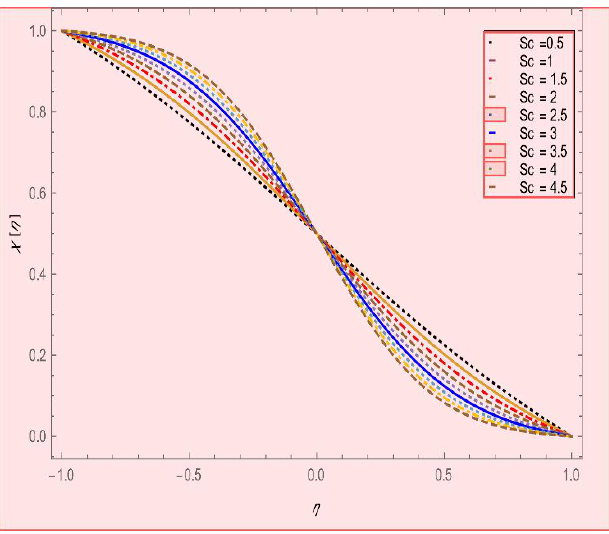
= ϕ = 0.01, Sc = 1, M = 1, Re = − 1, Pr = 6.2. 2 1